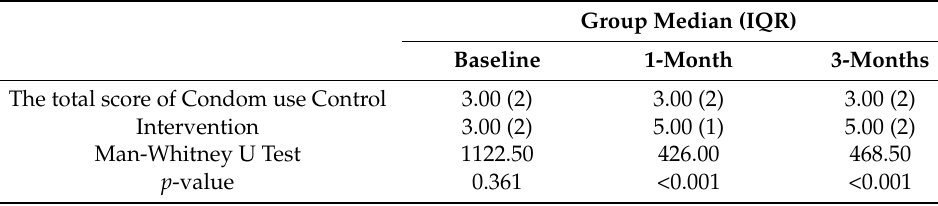
Table 2. Between-group difference of total scores of condom use